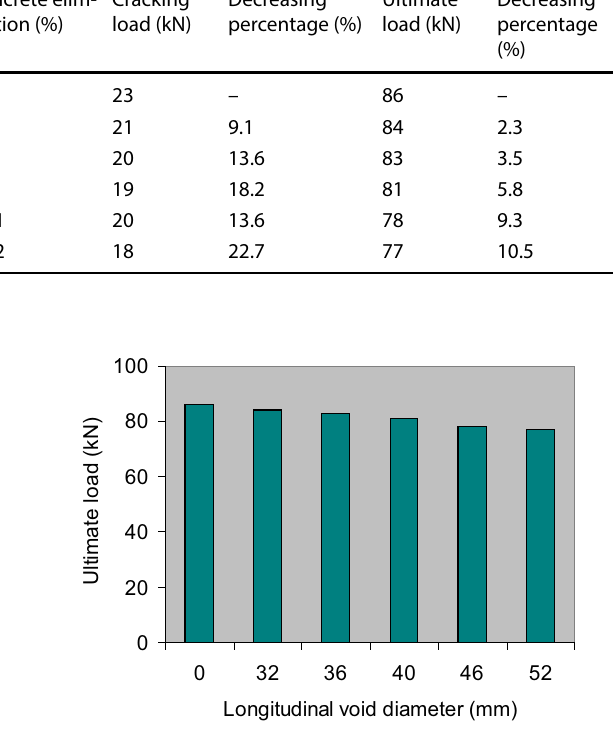
Fig. 6 Influence of longitudinal void diameter on ultimate